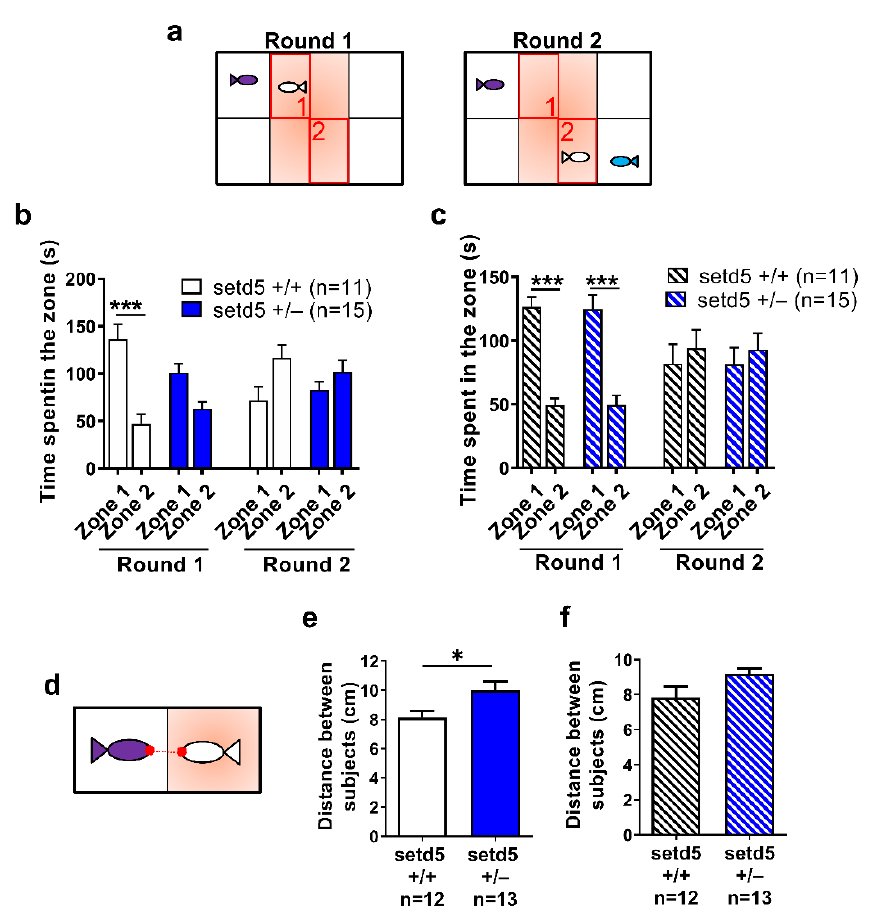
Figure 6. The antipsychotic drug Risperidone ameliorates the social behavior impairment of setd5 adult mutant zebrafish. ( a ) Set-up of zebrafish adult fish during the two rounds of social preference test on the fish (white) included in the central arena. Zone 1 and zone 2, highlighted in red, indicates the areas of the arena near to the first stimulus (purple) and social novelty stimulus (blue) added at round 2. ( b , c ) Time spent by setd5 +/+ and setd5 +/ − adult fish in zone 1 and zone 2, in both rounds of social preference test, for untreated ( b ) and Risperidone-treated fishes ( c ). ( d ) Set-up of the social behavior test, evidencing the distance between the nose points (in red) between the tested fish (white) and the social stimulus (purple). ( e , f ) Social behavior of setd5 +/+ and setd5 +/ − adult fish, evaluated in terms of distance between the nose points of the subjects, untreated ( e ) and Risperidone-treated fish ( f ). ( b , c , e , f ) Data are expressed as mean ± SEM; n = number of fish analyzed. ( b , c , e , f ) Statistical analysis was performed using ( b , c ) 1-way ANOVA followed by post-hoc test or ( e , f ) Student’s t -test. * p < 0.05; *** p <